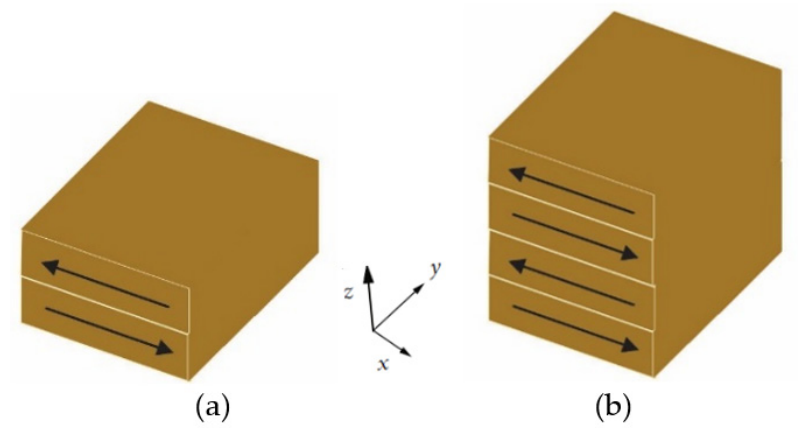
Figure 2. Sketch of the ( a ) two-stack and ( b ) four-stack d 15 shear actuators. Figure 3 shows photographs of the experimental assembly and corresponding cross- sectional views.